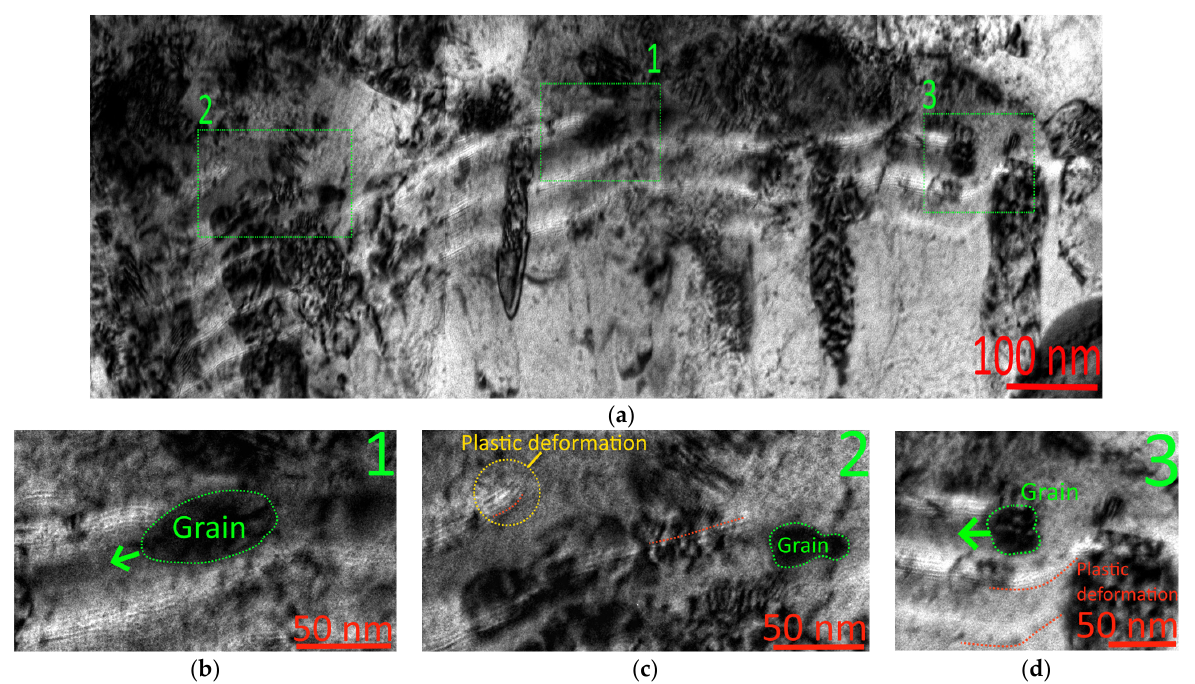
Figure 5. ( a ) Specifics of the interaction between the cut material flow and the structure of coating nanolayers, ( b – d ) penetration of grains of the machined steel into the structure of the coating. Figure 6 exhibit an example of the steel penetrating into the coating of the structure.